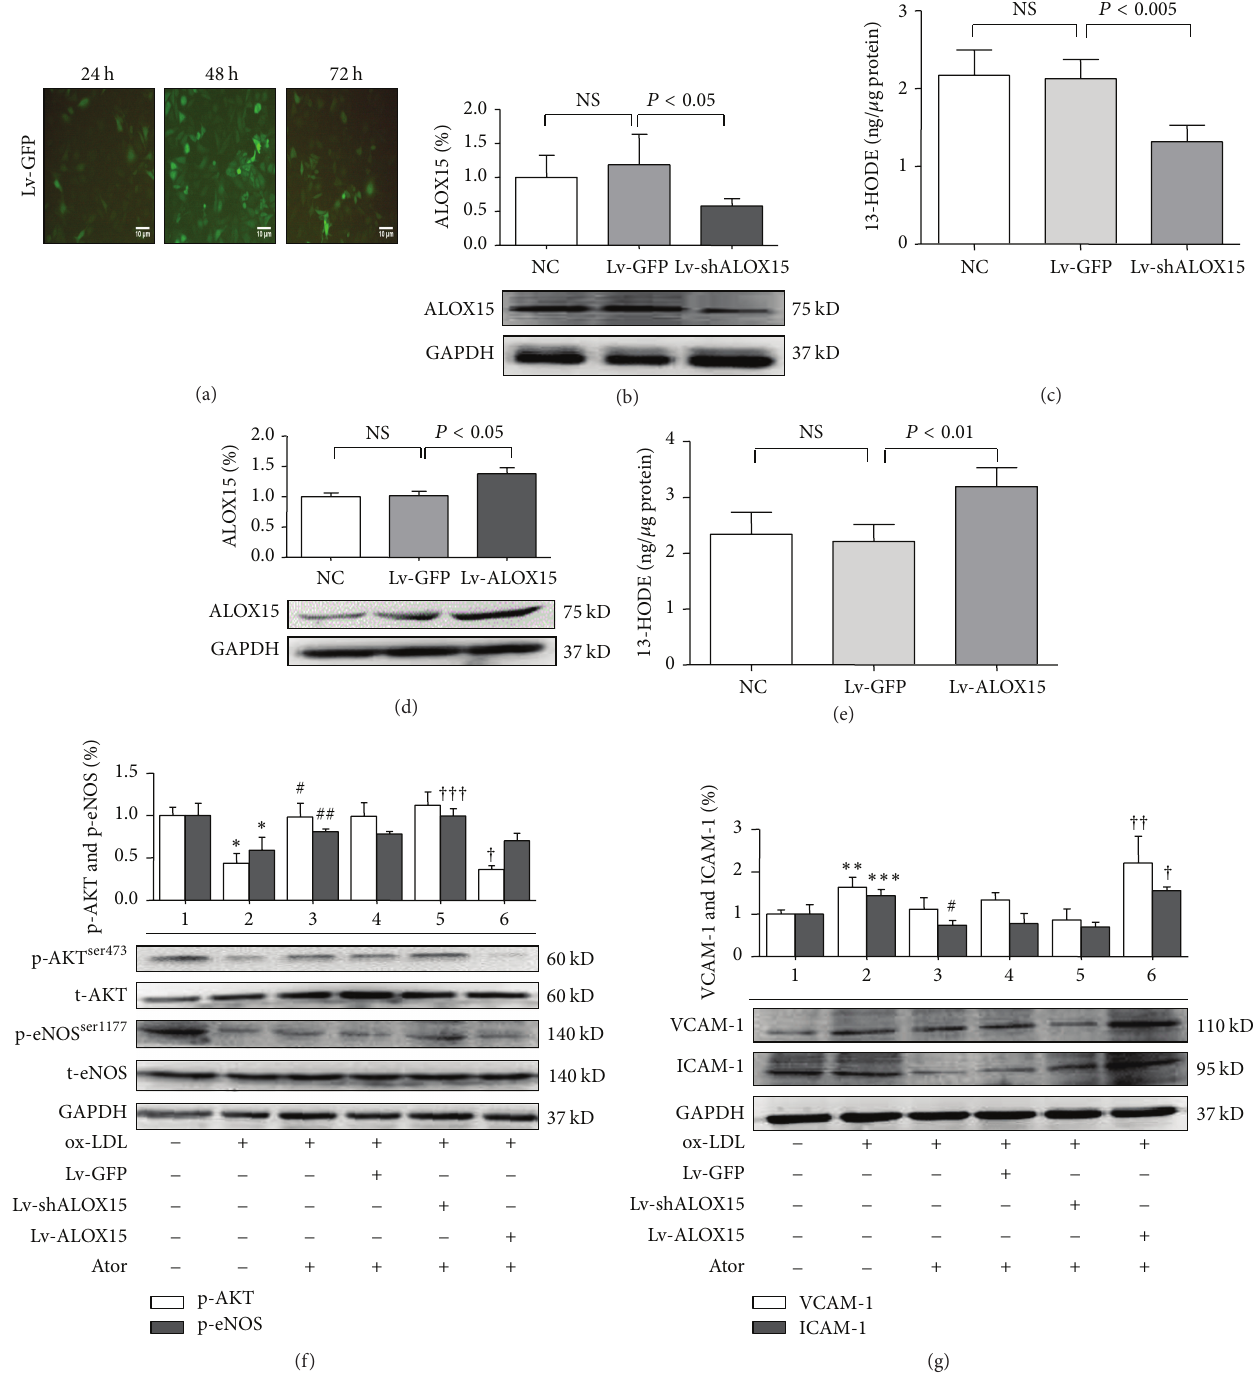
Figure 3: Changes in expression levels of ALOX15, AKT, eNOS, VCAM-1, and ICAM-1 in HUVECs 24 h following exposure to ox- LDL (100mg/L) or atorvastatin (10 𝜇 M). (a) Photographs of Lv-GFP-transfected HUVECs. GFP expression was visualized by fluorescence microscopy (100x) at 24, 48, and 72 h after transfection. The scale bar represents 10 𝜇 m. (b) and (c) Western blot and EIAs indicated that Lv-shALOX15 downregulated ALOX15 protein expression and enzyme activity. (d) and (e) Western blot and EIAs indicated that Lv-ALOX15 upregulated ALOX15 protein expression and enzyme activity. (f) Western blot analysis of AKT/eNOS expression in HUVECs. (g) Western blot analysis of VCAM-1/ICAM-1 expression in HUVECs. Group 1: normal control group; Group 2: ox-LDL (100 mg/L); Group 3: ox- LDL (100mg/L) + atorvastatin (10 𝜇 M); Group 4: Lv-GFP + ox-LDL (100mg/L) + atorvastatin (10 𝜇 M); Group 5: Lv-shALOX15 + ox-LDL (100mg/L) + atorvastatin (10 𝜇 M); and Group 6: Lv-shALOX15 + ox-LDL (100mg/L) + atorvastatin (10 𝜇 M). Results are expressed as mean ± SD. NC: normal control group; NS: not significant. ∗ 𝑃 < 0.001 , ∗∗ 𝑃 < 0.01 , and ∗∗∗ 𝑃 < 0.05 versus Group 1; # 𝑃 < 0.001 and ## 𝑃 < 0.05 versus Group 2; and † 𝑃 < 0.001 , †† 𝑃 < 0.01 , and ††† 𝑃 < 0.05 versus Group 4. 𝑁 = 4 per